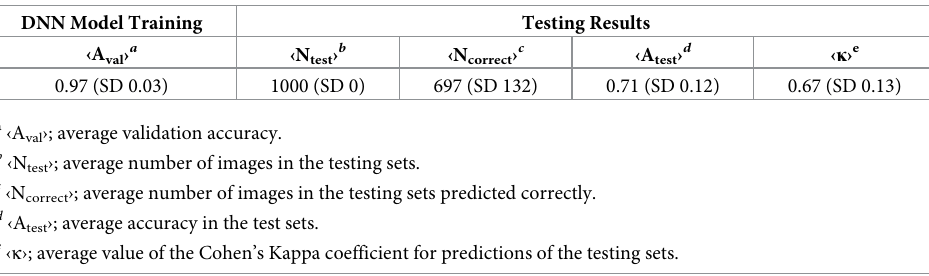
Table 3. Training of DNNs for recognition of ten lineages. Statistical summary for 80 DNN models used for classifi- cation of 28 antibodies belonging to ten family lineages using fingerprints colored according to the charge coloring